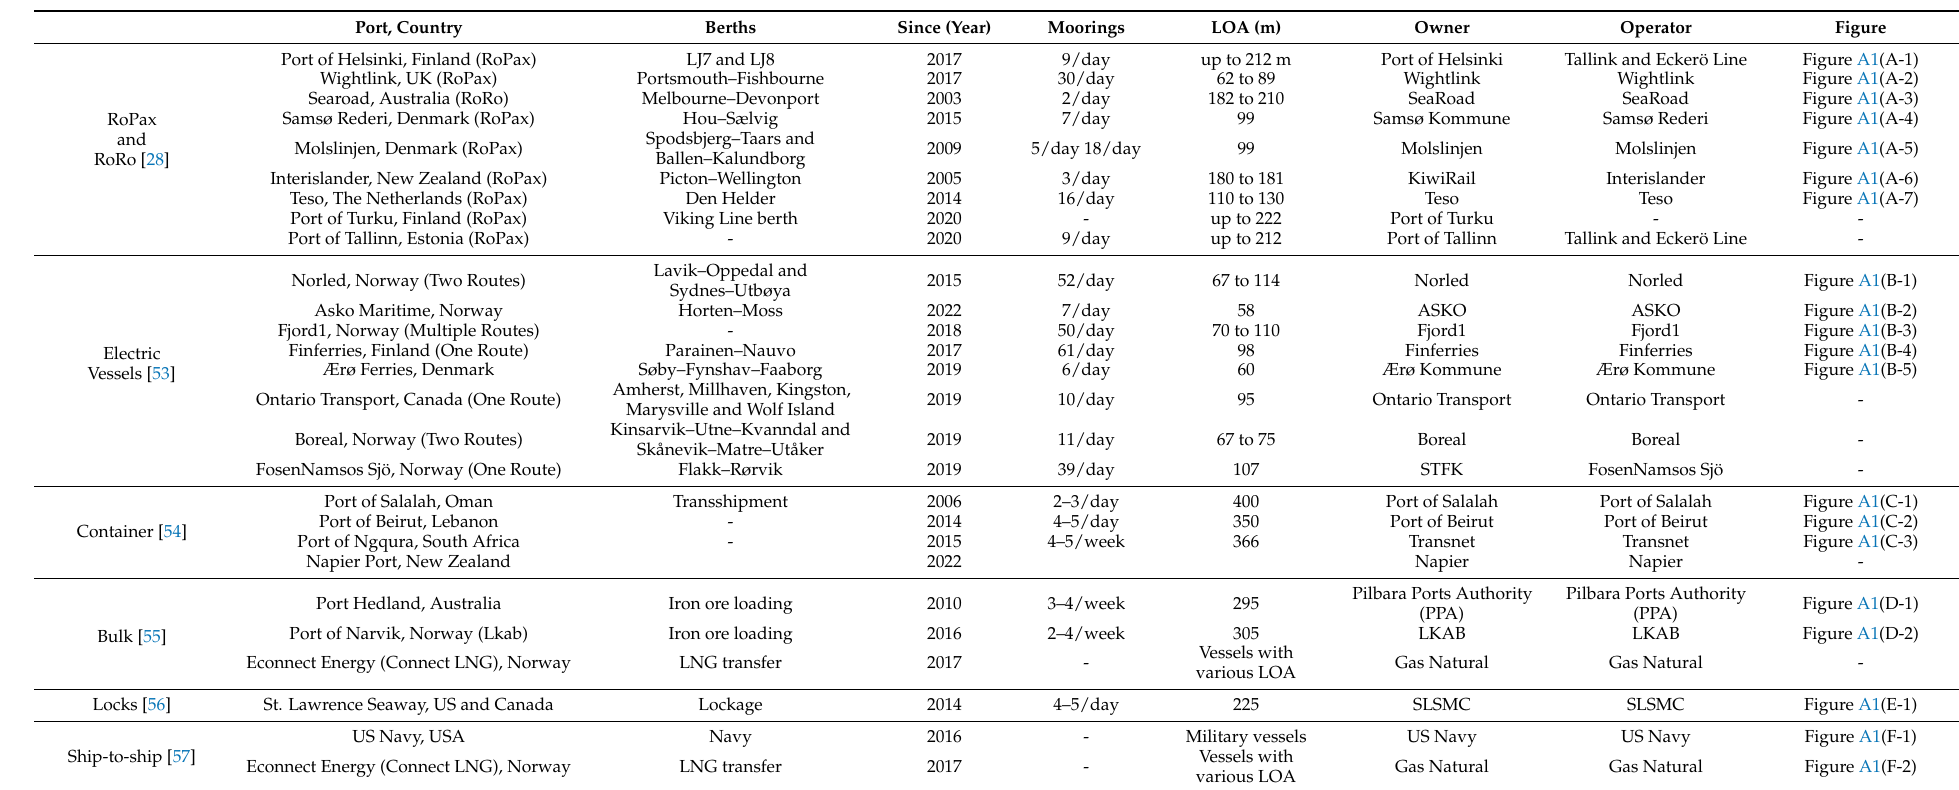
Port of Beirut, Lebanon Figure A1(C-2) Port of Ngqura, South Africa Figure A1(C-3) Napier Port, New Zealand